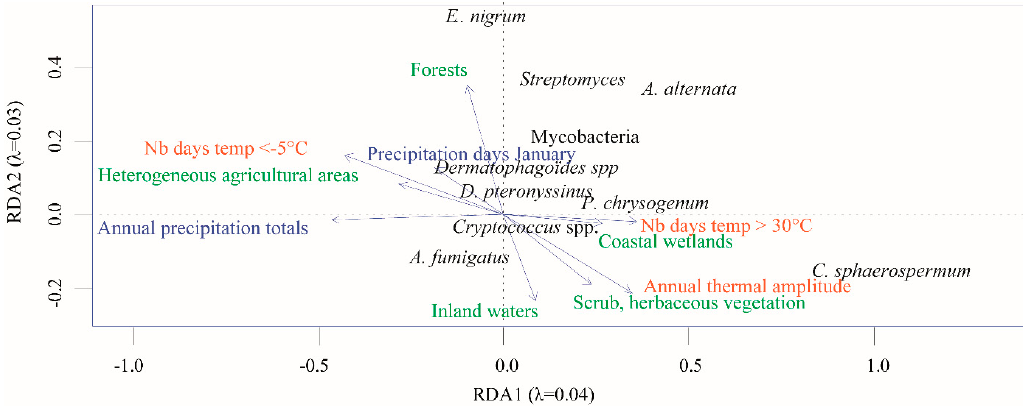
Figure 3. Partial redundancy analysis (pRDA) triplot showing target microorganisms and model selected climate and landscape variables. Microorganisms are in black, temperature variables in orange, precipitations variables in blue, and land cover in green.